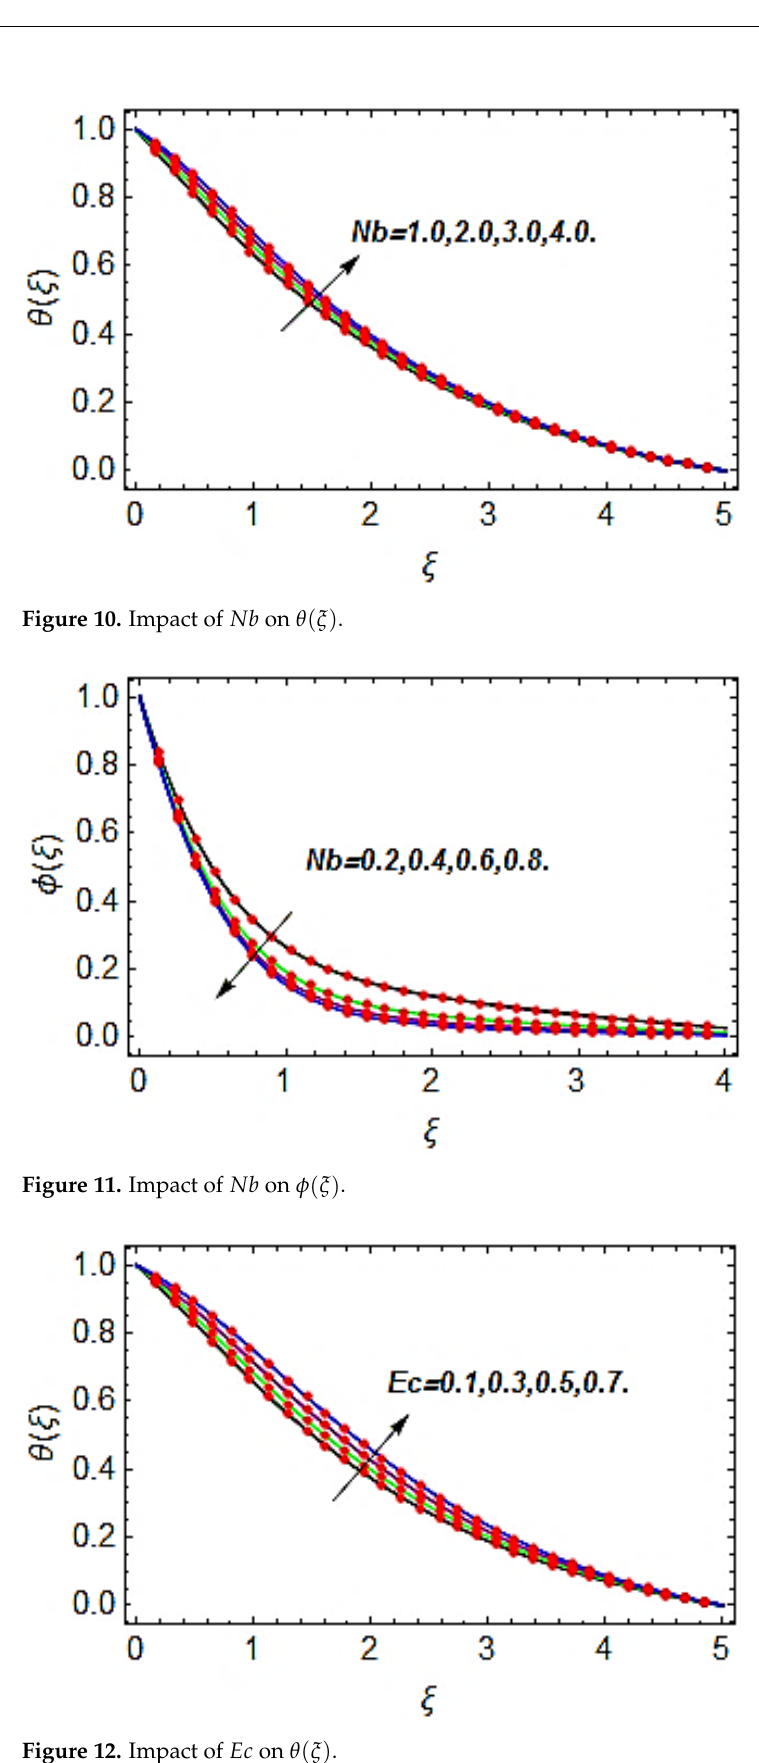
Figure 12. Impact of Ec on θ ( ξ )